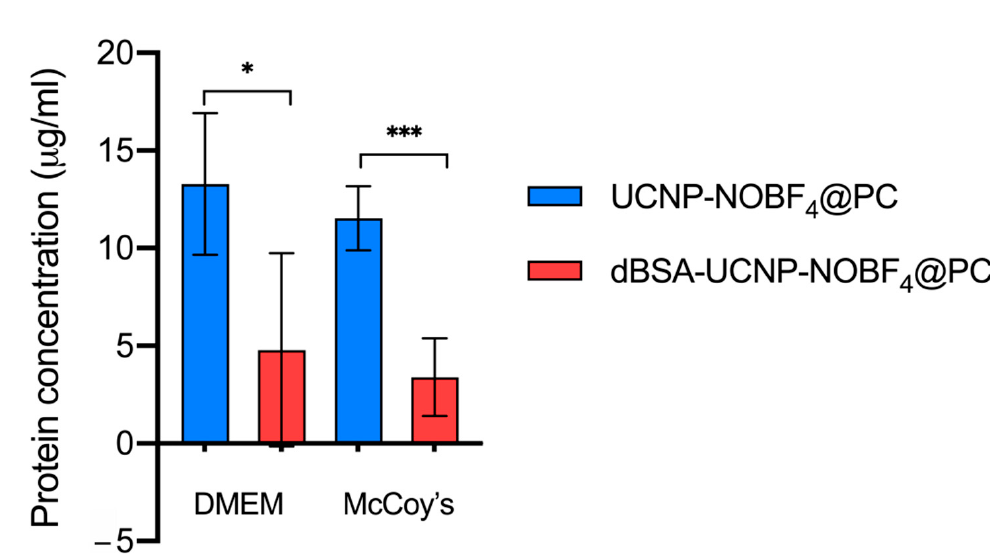
Figure 11. Hard protein corona quantification by micro-BCA assay. All samples were treated identically and subject to three cycles of washing with PBS. Protein corona formation on the surface of lyophilized dBSA-UCNP-NOBF 4 was calculated after eliminating the dBSA background. The results were analyzed with an unpaired t-test (n = 5; *: p < 0.05, ***: p < 0.001) using GraphPad Prism 9.